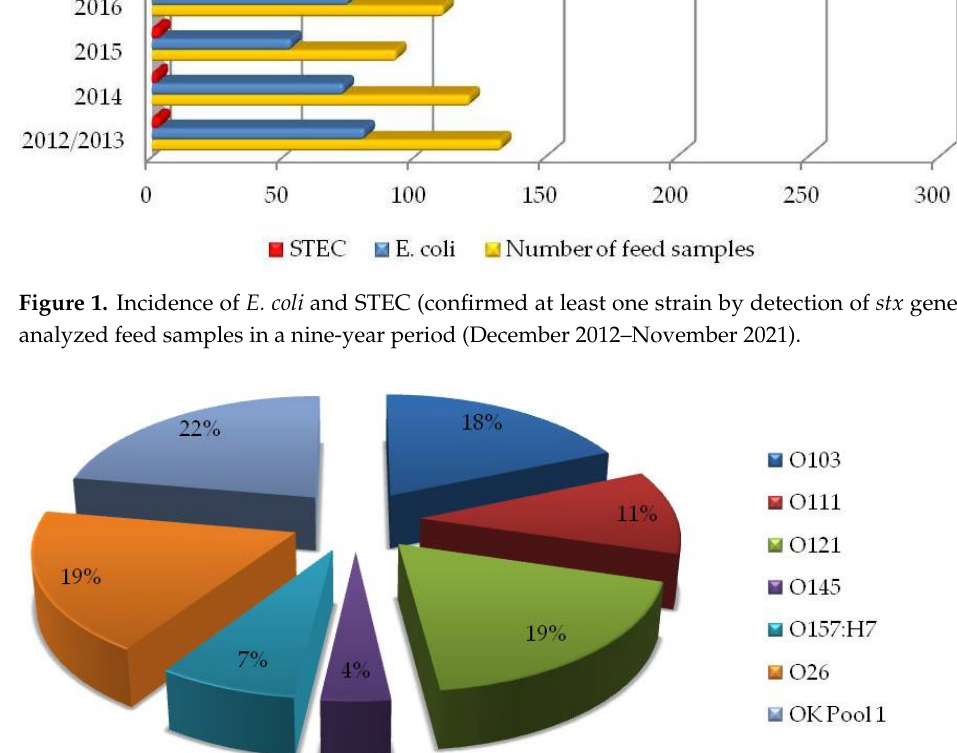
Figure 1. Incidence of E. coli and STEC (confirmed at least one strain by detection of stx genes) in analyzed feed samples in a nine-year period (December 2012–November 2021).